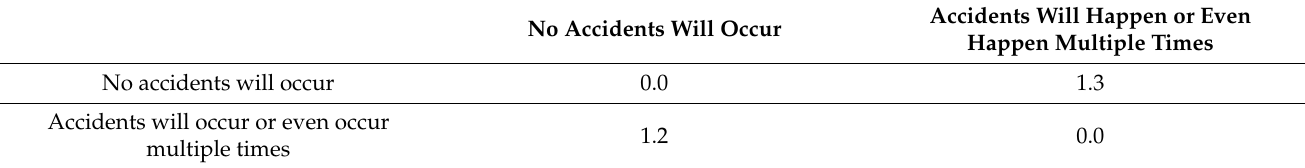
Table 11. Misjudgment